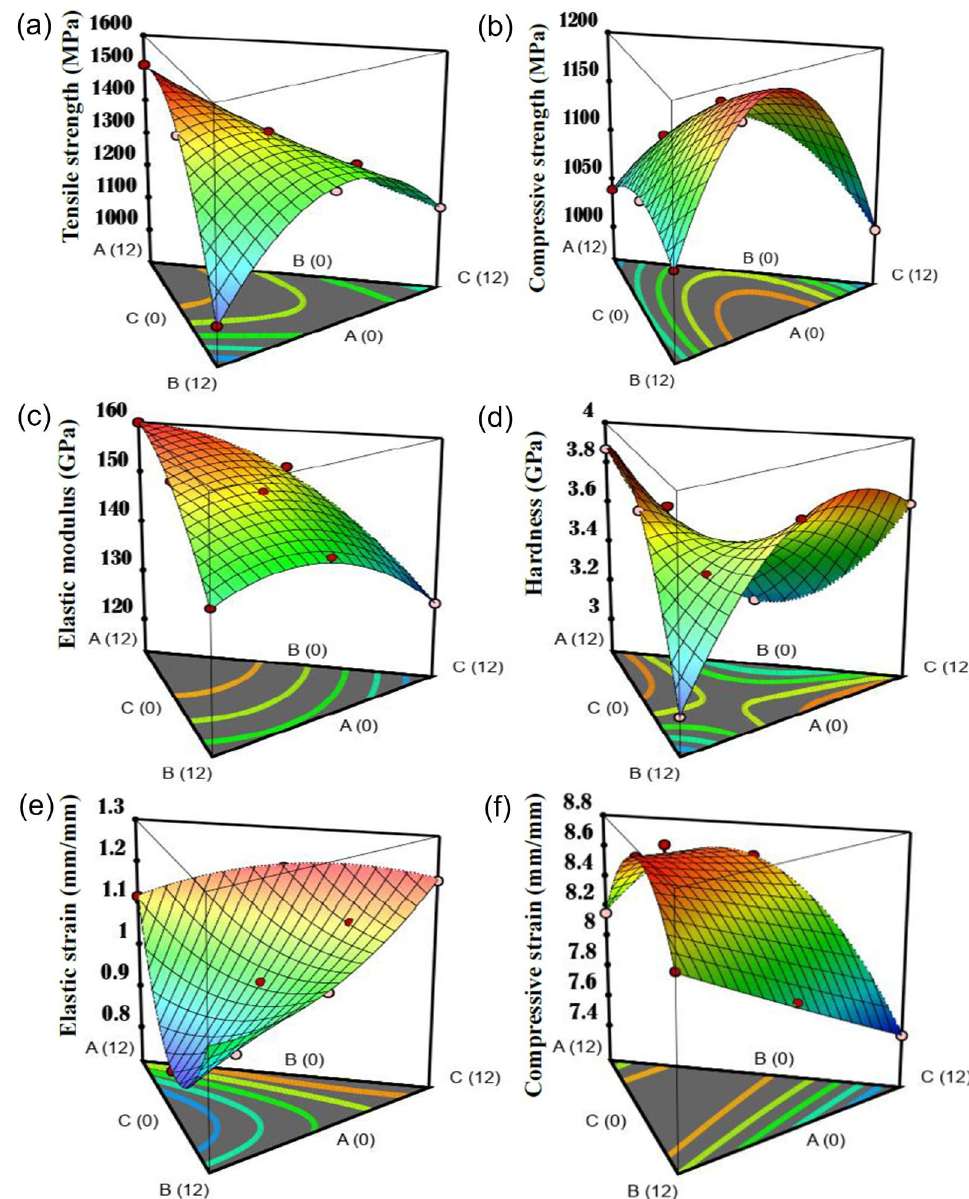
Figure 6. Surface plots for response parameters: ( a ) tensile strength, ( b ) compressive strength, ( c ) elastic modulus, ( d ) hardness, ( e ) elastic strain, and ( f ) compressive strain.